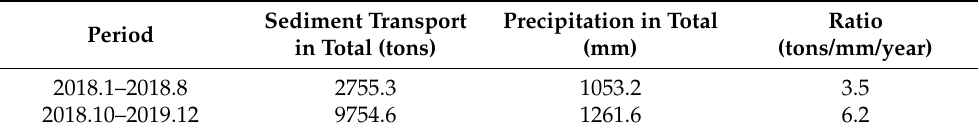
Figure 9. Correlation between turbidity with sediment transport before and after the 2018 Hokkaido Eastern Iburi Earthquake at Kyoei Station. Table 5. The amount of sediment transport per unit rainfall before and after the 2018 Hokkaido Eastern Iburi Earthquake at Kyoei Station.